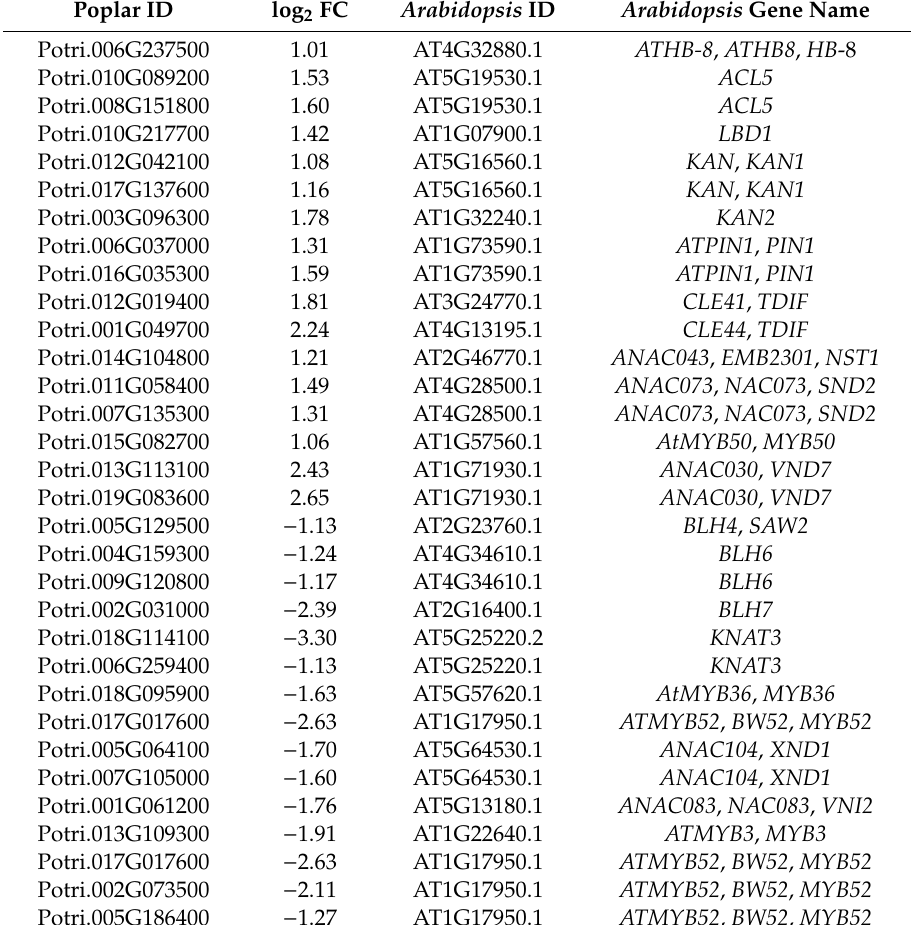
Table 3. Differentially expressed genes involved in vascular identity in 21 dai galls versus uninfected roots. Poplar